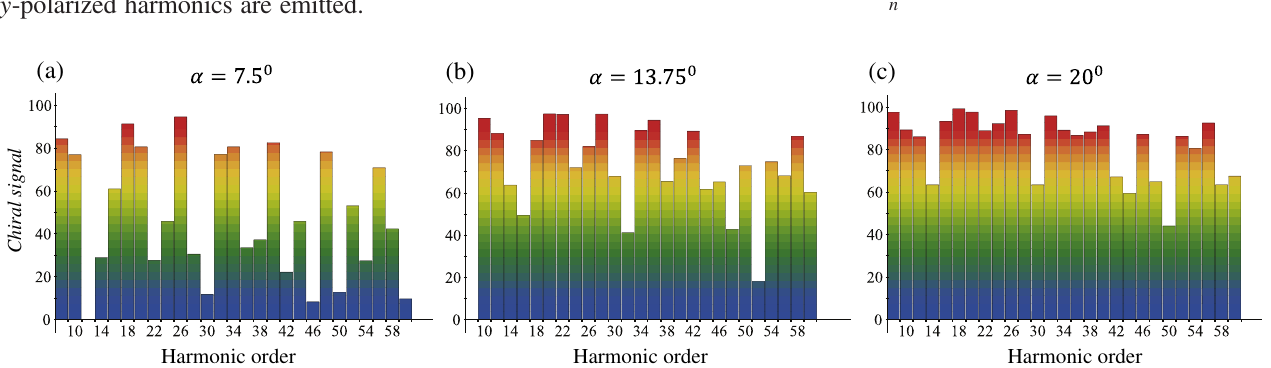
FIG. 9. Dynamical inversion symmetry-breaking-based chiral selectivity in HHG from DFT-based model calculations for CBrClFH. (a) – (c) Chiral signal per harmonic order defined through the harmonic integrated y -polarized yield for fundamental wavelength λ ¼ 3300 nm, frequency ratios 3 ω - 5 ω in the pump field, I α ¼ 7 . 5 0 ; 13 . 75 0 ; 20 0 , and a trapezoidal envelope with four-cycle turn-on/off and three-cycle